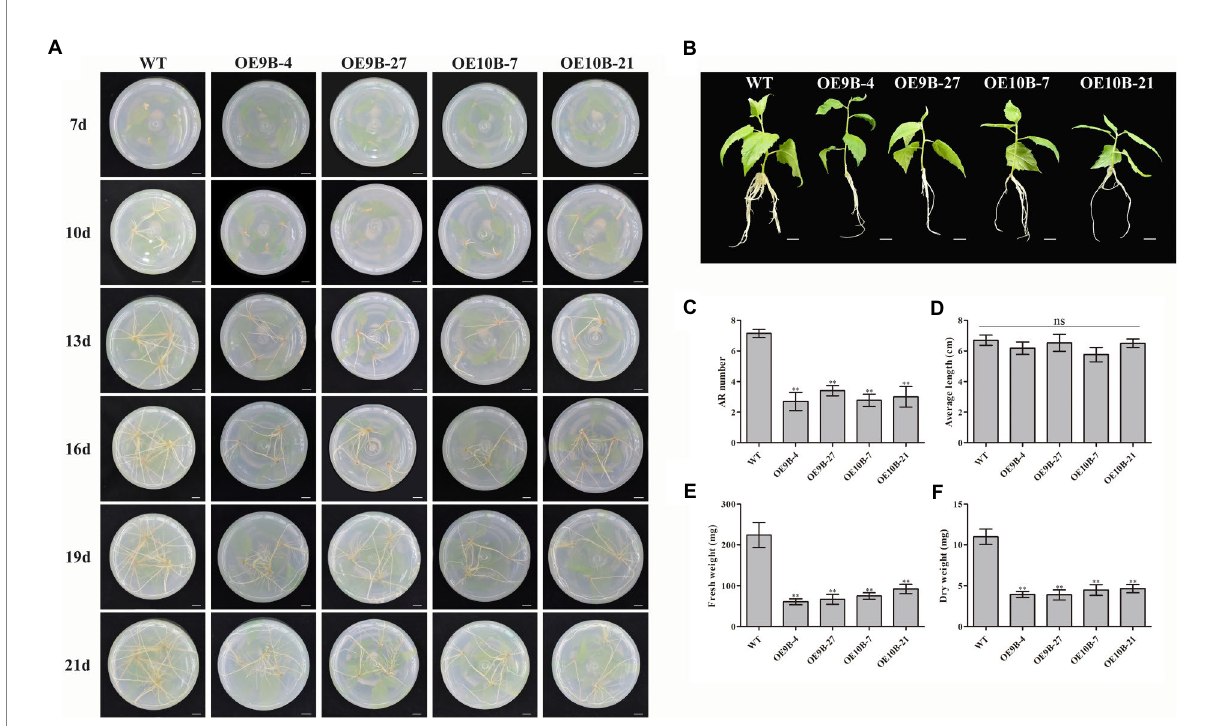
FIGURE 5 Phenotypes of transgenic lines and WT cuttings 3 weeks after establishment in rooting medium. (A) The adventitious roots of transgenic lines and WT formed and developed over time. Bar = 1 cm. (B) Images of cuttings from different lines 3 weeks after establishment. Bar = 1 cm. (C) AR number between different lines. (D) Average length of ARs between different lines. (E) Fresh weight of ARs between different lines. (F) Dry weight of ARs between different lines. The experiments were performed three times and the similar results were obtained, at least six 84K poplars were collected as a replicate. The bars represent means ± SE ( n = 6) and the asterisks indicate significant differences between WT and transgenic plants ( * p < 0.05, ** p <